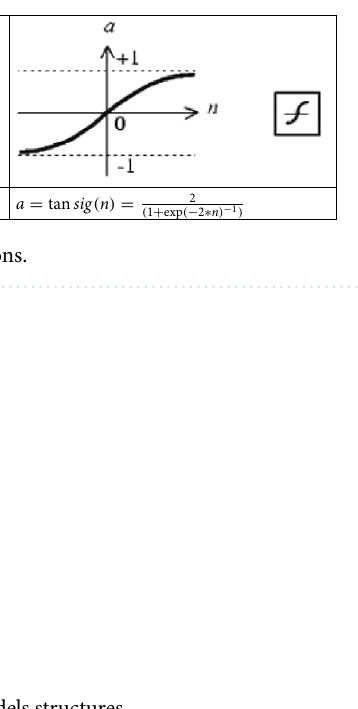
Figure 6. Optimized number of neurons for RBF and MLP models structures.